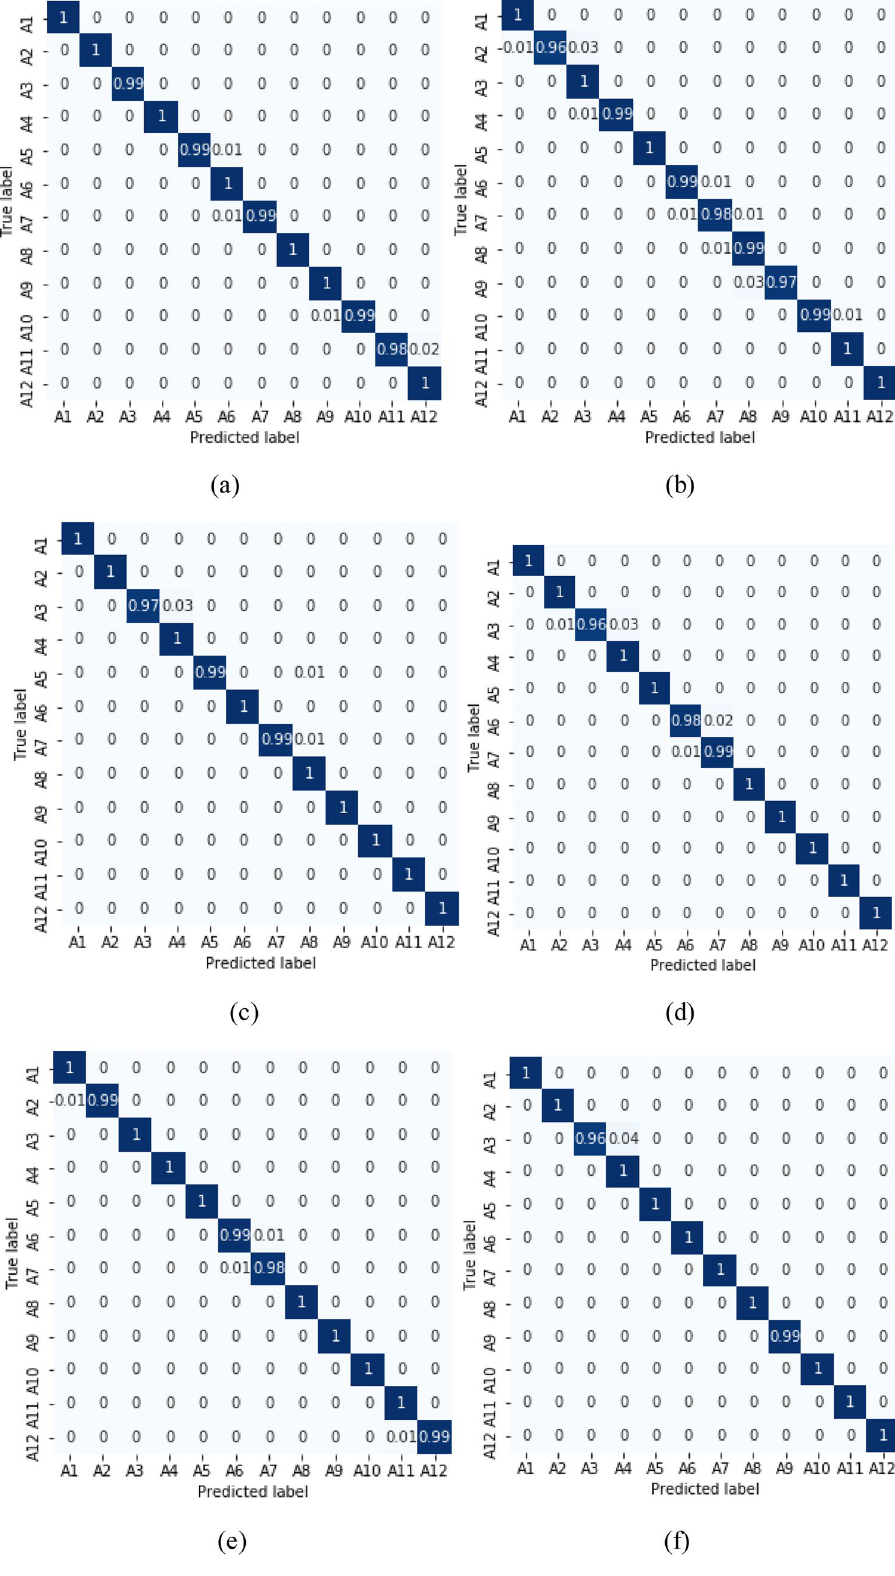
Figure 8. Confusion matrices of fold 1–6 from (a) to (f) using